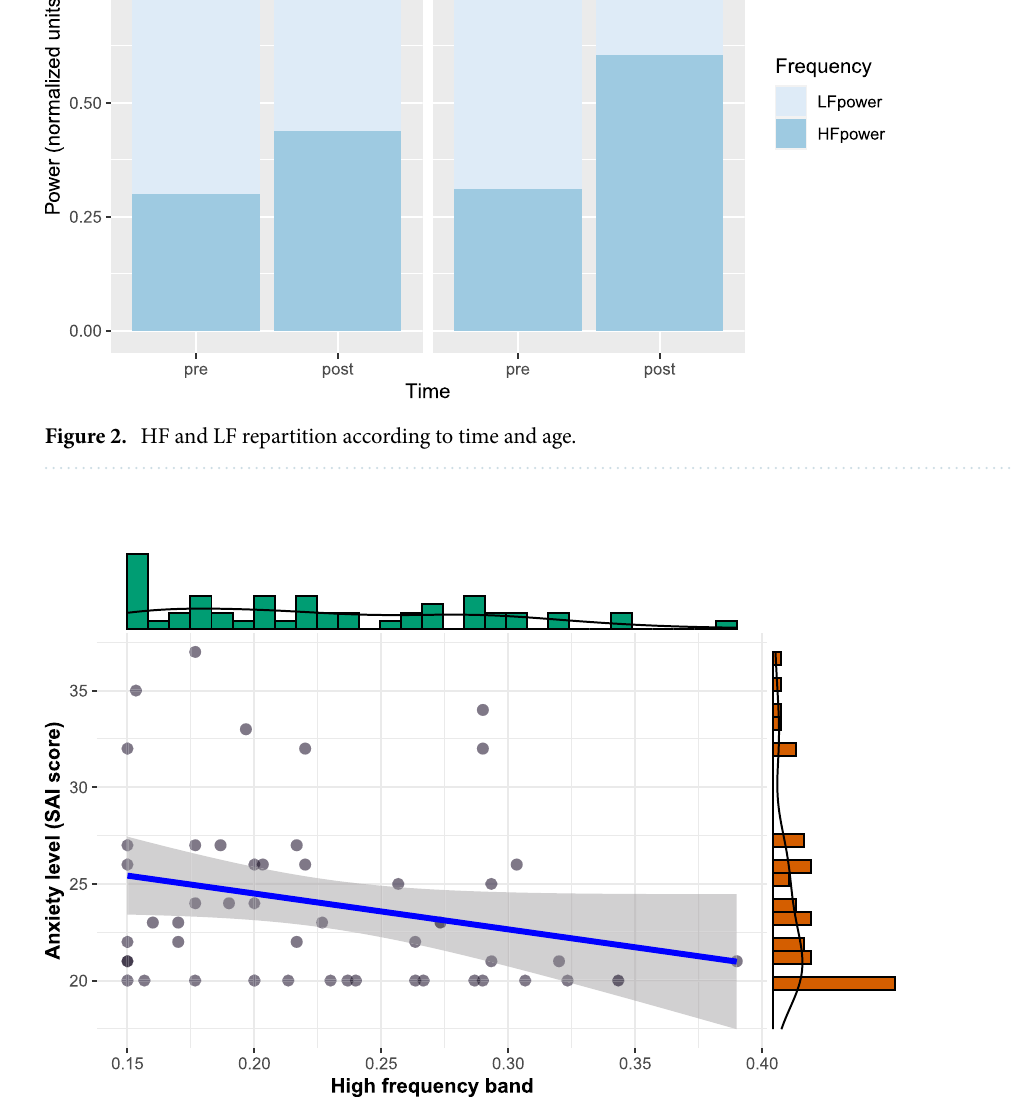
Figure 3. Negative association between HF and post-DSB anxiety